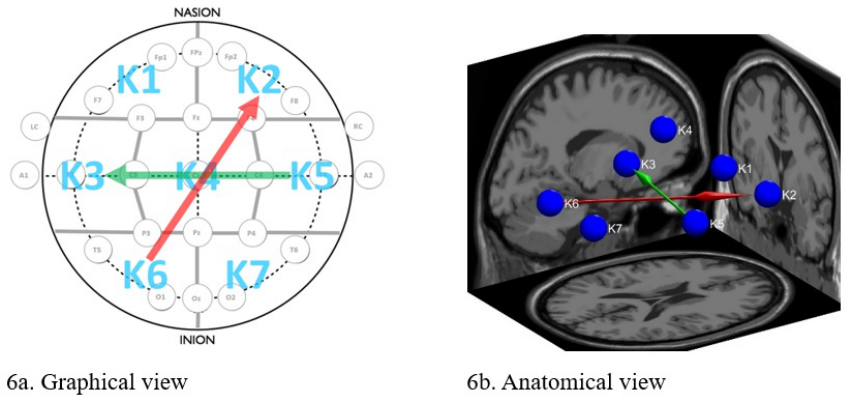
Figure 6. Estimated brain connectivity in the problem-identifying phase for numerical intelligence tasks. Note: Arrows represent causality directions (green arrow: engineering > liberal arts; red arrow: liberal arts > engineering).